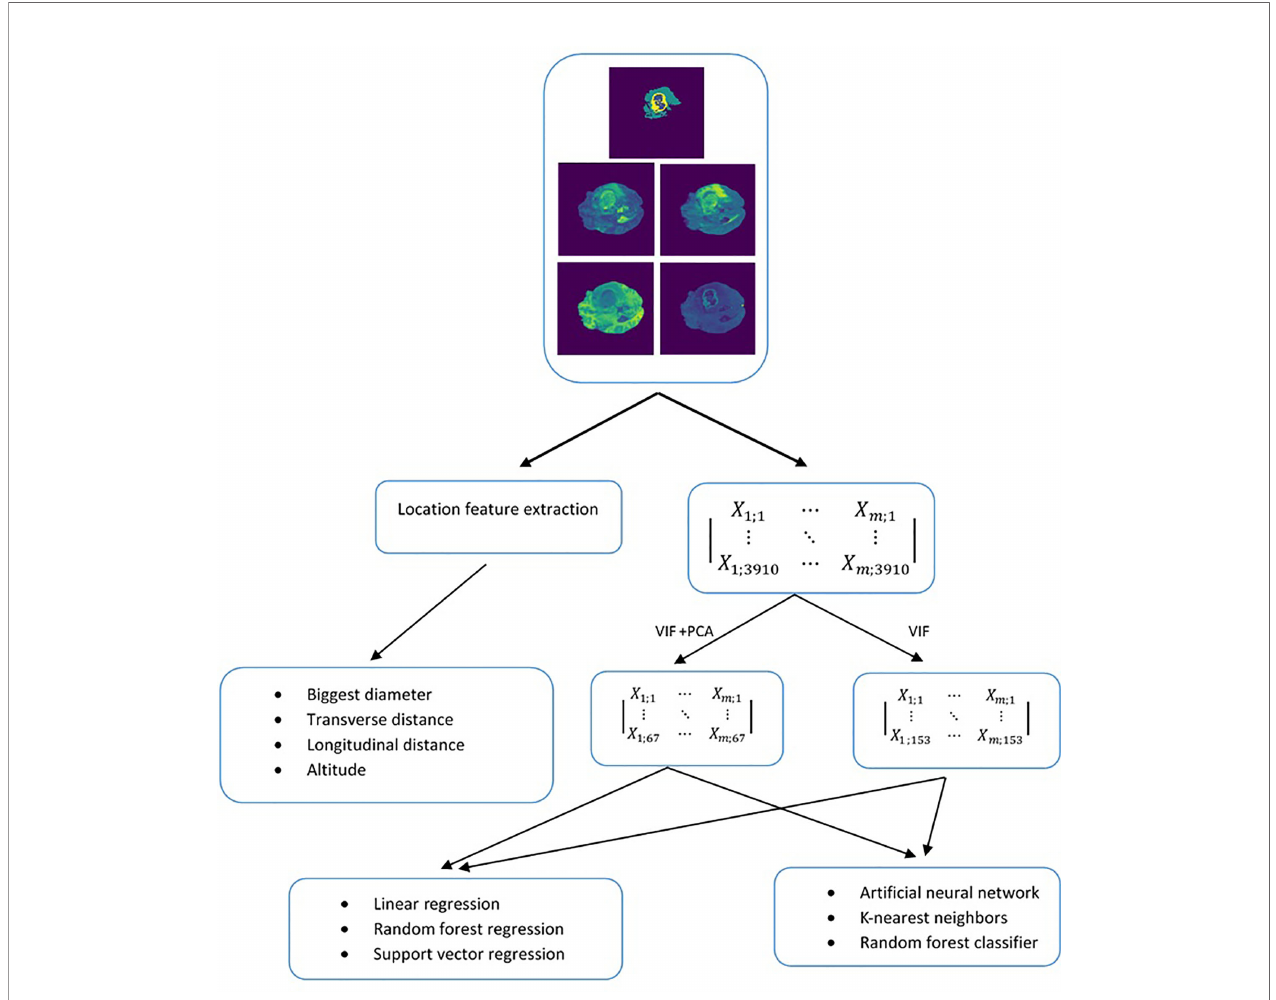
(cid:129) Shape-based (3D) (cid:129) Shape-based (2D) (cid:129) Gray Level Co-occurrence Matrix (cid:129) Gray Level Run Length Matrix (cid:129) Gray Level Size Zone Matrix (cid:129) Neighboring Gray Tone Difference Matrix (cid:129)